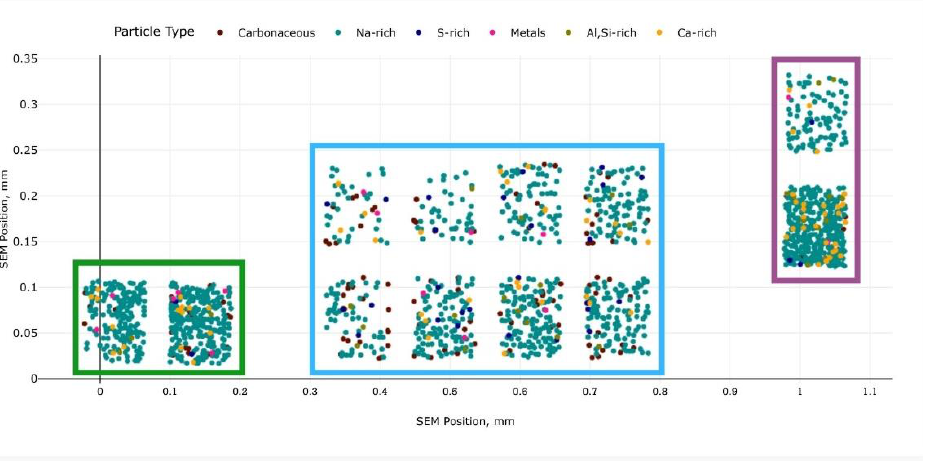
Figure 9. Distribution of the 6 particle types over the analyzed areas identified in Figure 7. Each point represents a particle and each color a particle type. A total of 405, 763 and 567 particles are observed in the green, blue and purple areas, respectively.